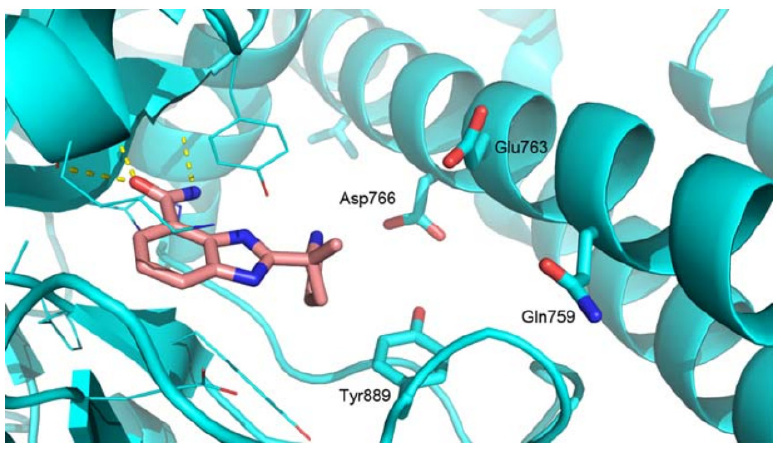
Figure 2. X-Ray co-crystal structure of veliparib with PARP-1 [16].